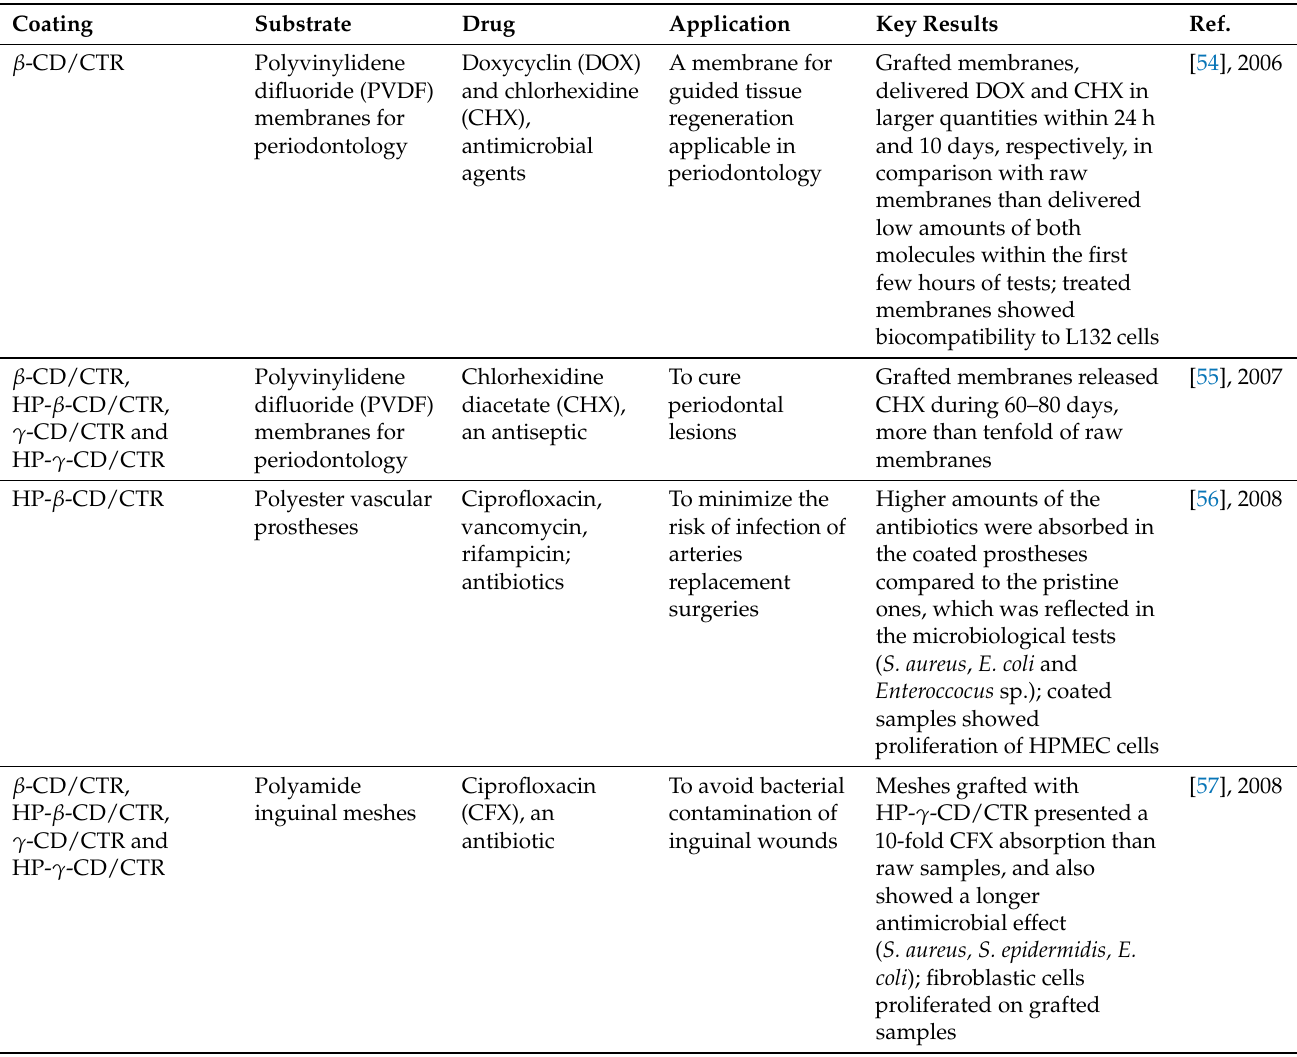
Table 3. Applications of coatings of cyclodextrin/citric-acid biopolymers as drug-delivery systems (Part 1).